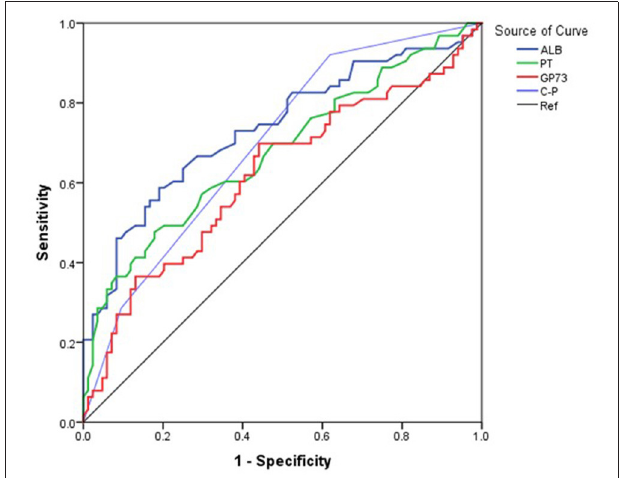
FIGURE 1 | Diagnostic accuracy of individual variables in the prediction of esophageal variceal hemorrhage. The ROC curve was used to represent the prediction model for hemorrhage using a single clinical marker, with the AUC indicating the value of the prediction model. The ROC curve was plotted based on the data in Table 3 . Different colored lines represent different predictors. Blue: ALB, Green: PT, Red: GP73, Purple: (C-P), Black: Reference (Ref).